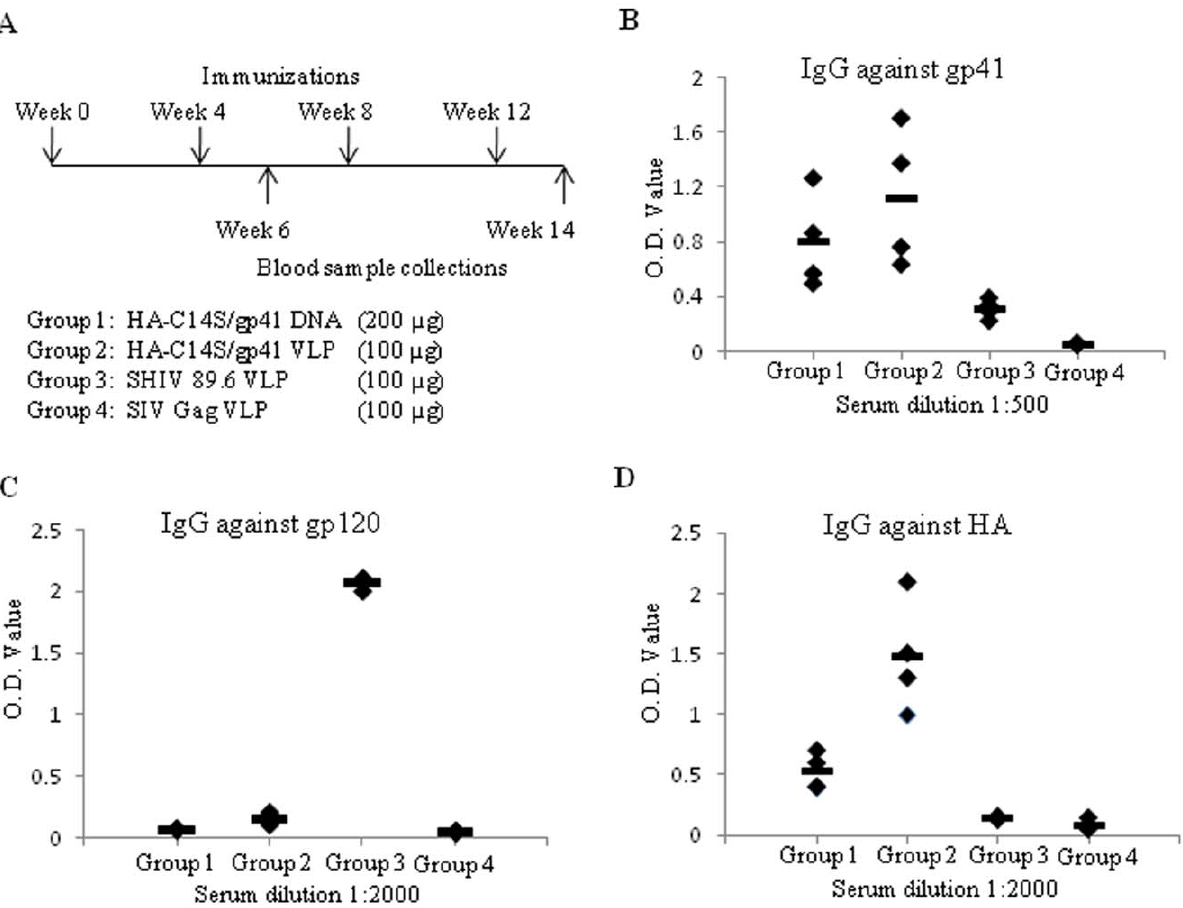
Figure 3. Immunization of guinea pigs and analysis of antibody responses. Guinea pigs (groups of 4) were immunized 4 times at 4-week intervals with HA-C14S/gp41 DNA (Group 1, 200 m g DNA per guinea pig per dose), HA-C14S/gp41 VLP (Group 2, 100 m g VLP per guinea pig per dose), SHIV 89.6 VLP (Group 4, 100 m g VLP per guinea pig per dose), or SIV Gag VLP (Group 4, 100 m g VLP per guinea pig per dose) as indicated, and blood samples were collected at 2 weeks after the second and fourth immunizations ( A ). The levels of antibody responses against HIV gp41 ( B ), HIV gp120 ( C ), or influenza HA ( D ) in sera from individual guinea pigs after 4 immunizations were determined by ELISA as described in Materials and Methods, and were expressed by the O.D. values at indicated serum dilutions for each antigen.